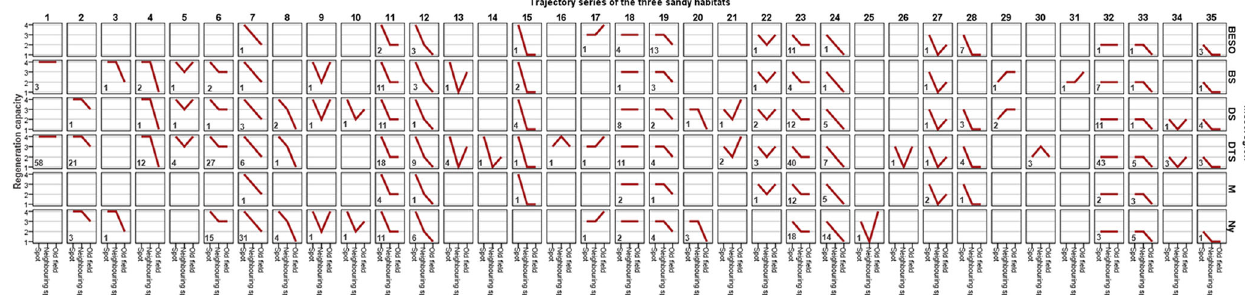
Fig. 2 Spatial regeneration trajectories of the three habitat types in the studied mesoregions. Sandy habitat types in the Hungarian mesoregions: open sand grasslands n = 223, closed sand grasslands n = 363, and poplar-juniper sand dune forests and thickets n = 51; x-axis: three different locations (spot, neighboring spot, old- fi eld); y-axis: regeneration capacity (good (4), moderate (3), low (2), none (1)). The abbreviations for each mesoregion: BESO Bels ő - Somogy, BS Bácskai-síkvidék, DS Dunamenti-síkság, DTS Duna-Tisza közi síkság, M Mez ő föld, Ny Nyírség. The numbers in the boxes represent the exact values of each spatial regeneration classi fi cation accuracy 0.65; error rate 39%), the main environ- mental predictor determining the spatial regeneration trajectories was temperature seasonality (importance 16.4%), followed by topography (15.6%), groundwater level (13.4%) and naturalness (13.4%), and to a lesser extent by other environmental factors.